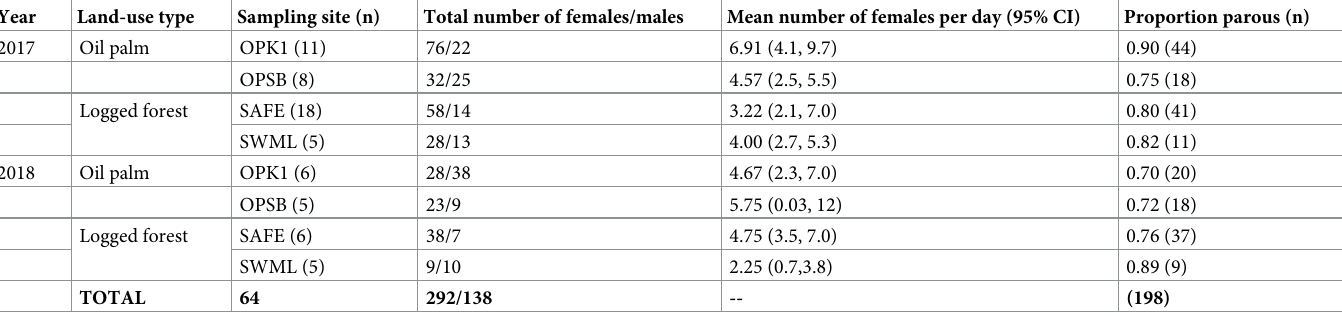
Table 2. Human landing catch data. Sampling sites are listed along with the number of sampling days per site (n). For the proportion of parous females, n indicates the total number of females for which parity status could be determined.